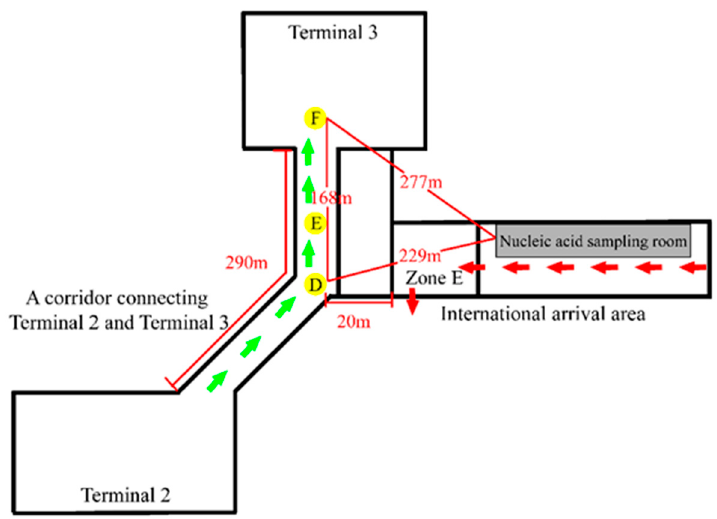
Figure 2. Schematic plan of Xi’an Xianyang International Airport. Distance between different sites is marked in the diagram. Green arrows and red arrows represent walking routes of case a, b and inbound international flight passengers. D–F: Monitoring and sampling points set at the Terminal 2 – Terminal 3 corridor and the Terminal 3 hall at different distances.